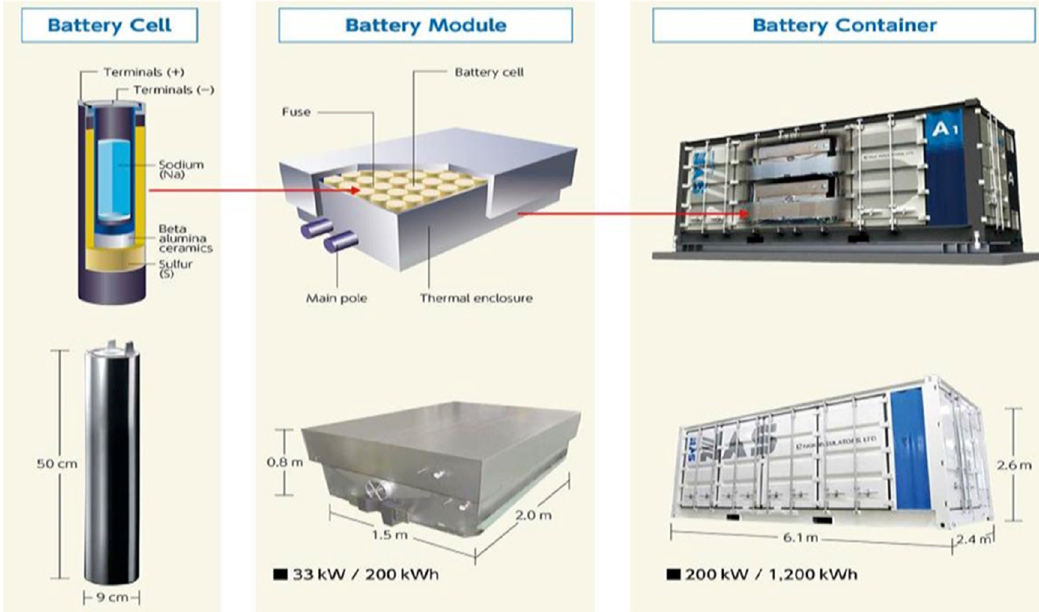
Fig. 7. NaS battery storage system.